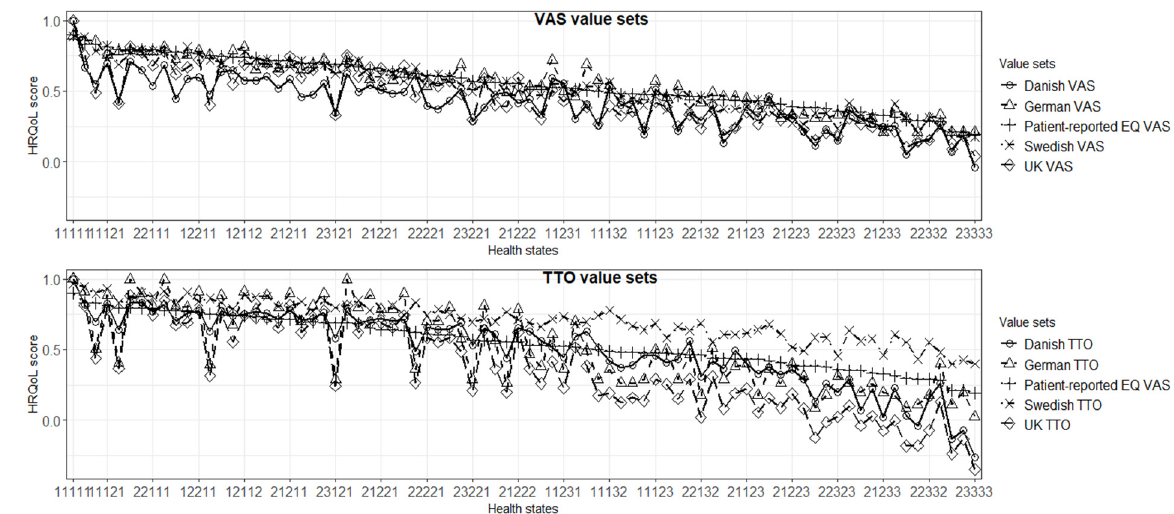
Figure 2. Comparison of patient-reported EQ VAS score with EQ-5D-3L indices based on the value sets 1 year postoperatively (ordered by patient-reported EQ VAS) ( n = 73,523).